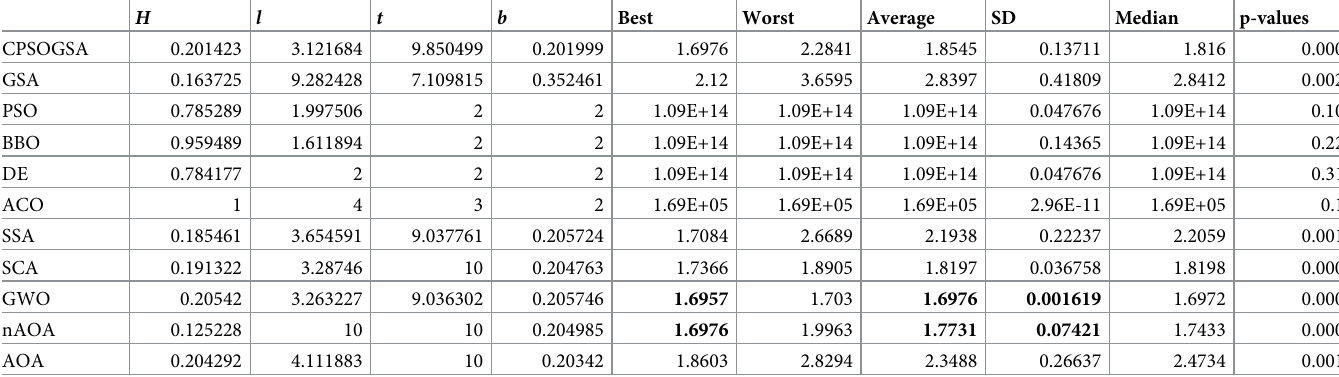
Table 6. Results for experiment conducted for